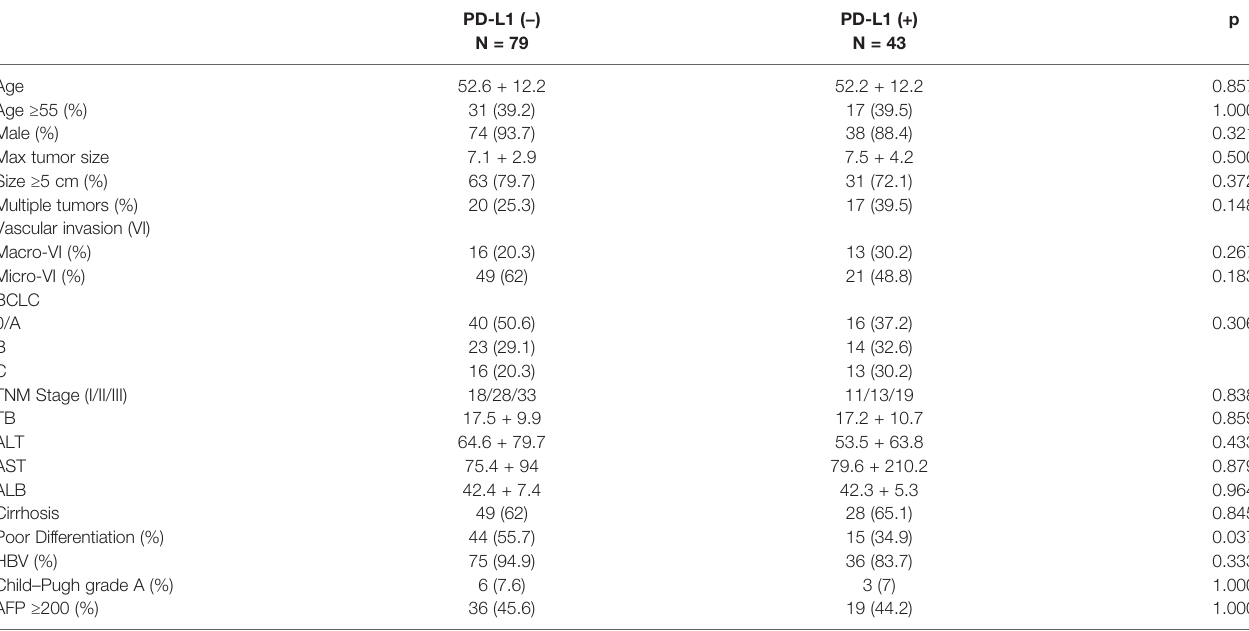
TABLE 2 | Comparison of baseline characters of 122 patients with high risk of recurrence concerning PD-L1